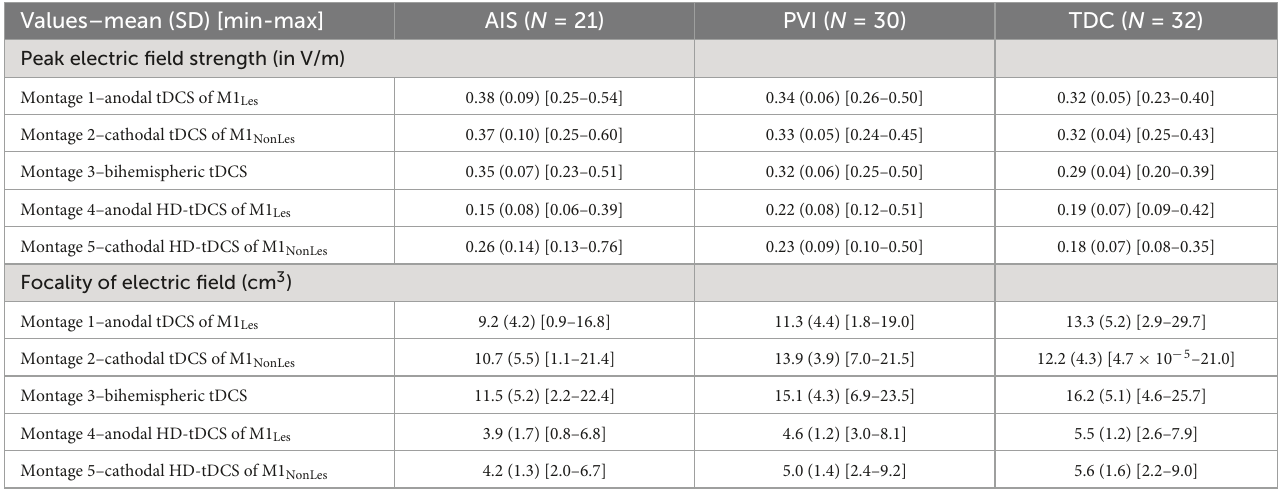
TABLE 2 Gray matter peak electric field strength and field focality for five tDCS montages by participant group. Values–mean (SD) [min-max] AIS ( N = 21) PVI ( N = 30) TDC ( N = 32)